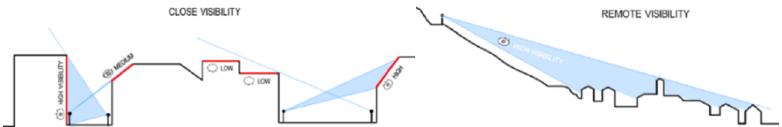
Figure 4. Levels of close ( on the left ) and remote ( on the right ) visibility of PV surfaces from public domain. Reproduced with permission from Maria Cristina Munari Probst, Christian Roecker, Solar Energy; published by Elsevier, 2019 [15,24].